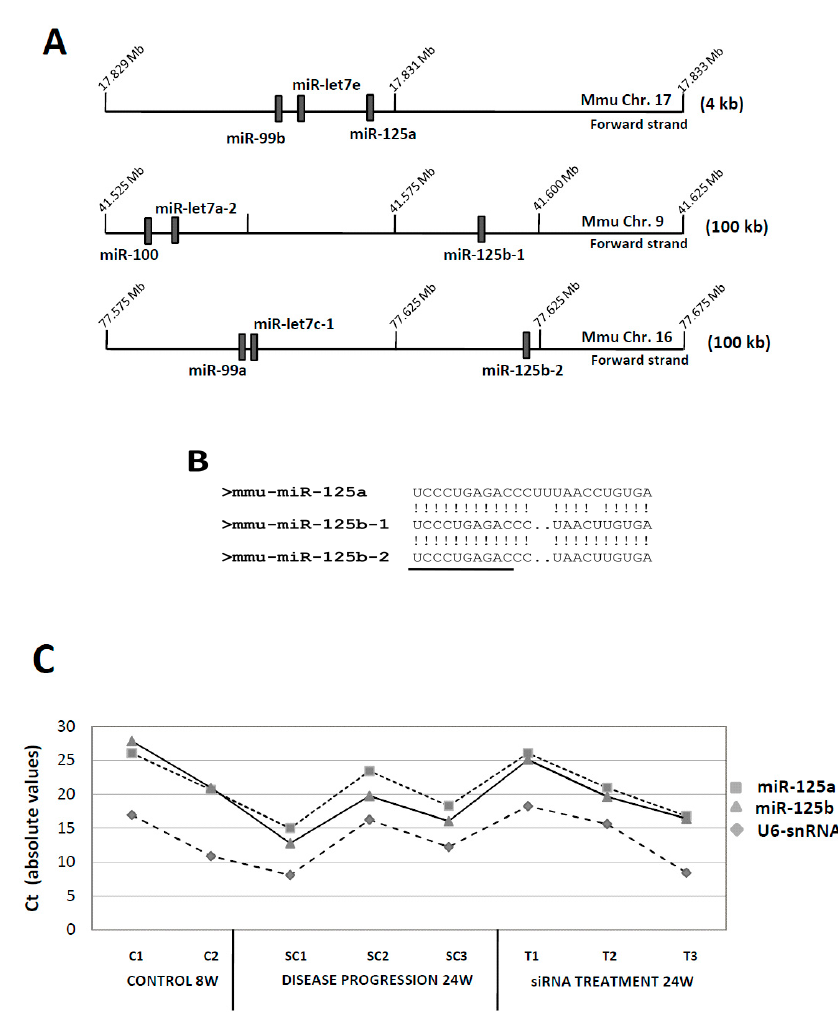
progression (6.7 ± 0.6 vs. 3.97 ± 0.6 cycles, respectively; n = 3) and returned to almost basal levels after treatment with the anti-CD40 siRNA (7.16 ± 1.6 vs. 6.26 ± − 2.0 cycles, respectively; n = 3). Given the cycles, respectively; n = 3). Given the small differences in the expression of miR-125a and miR-125b, small differences in the expression of miR-125a and miR-125b, we considered that miR-125a could also we considered that miR-125a could also have a role, though perhaps less relevant that miR-125b, in have a role, though perhaps less relevant that miR-125b, in ATH progression. ATH progression.